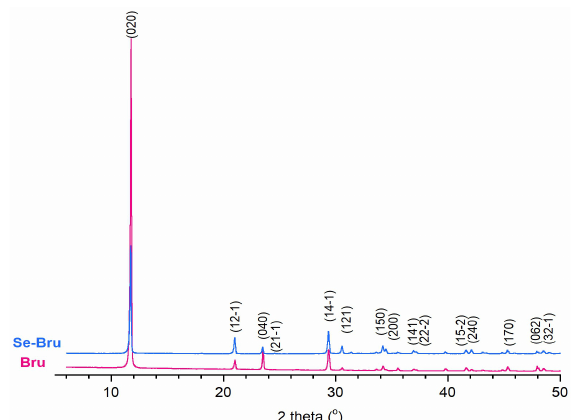
Figure 2. Powder X-ray Diffractometry (PXRD) patterns of Bru and Se-Bru. Table 1. Various parameters of the obtained materials.